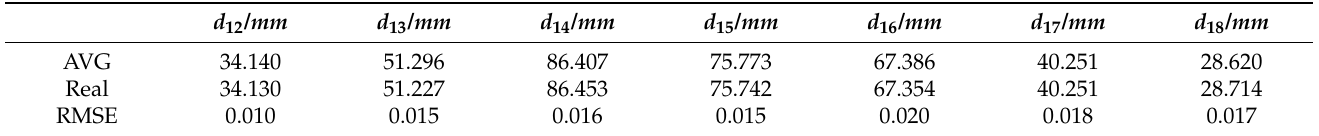
Table 4. Comparison of the distance measured result with the actual